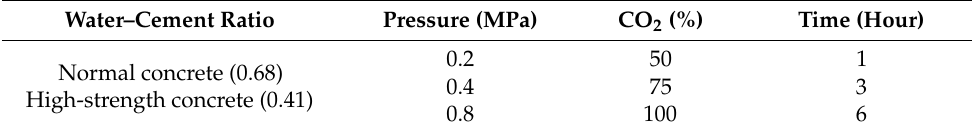
Table 3. Combination factors of concrete CO 2 curing test.